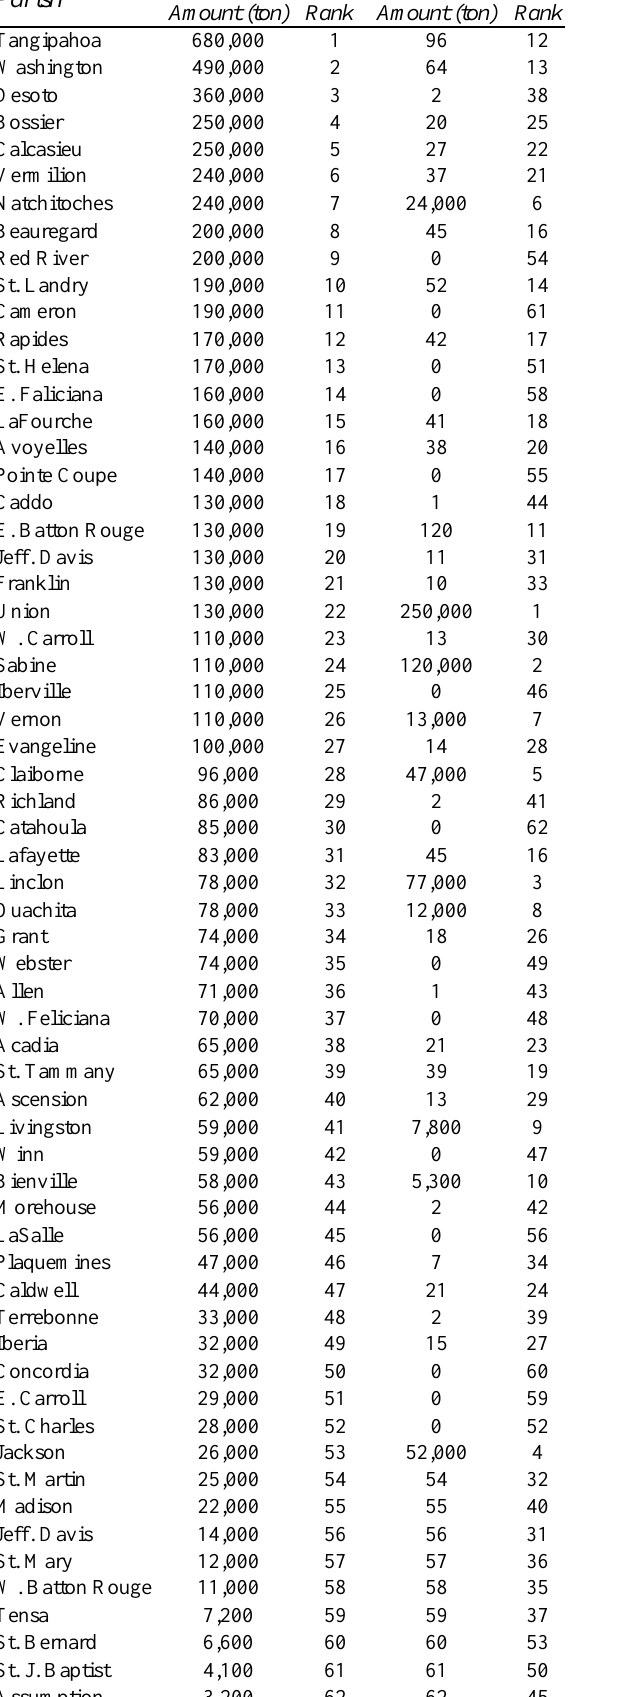
Table 3: Amount of cattle and poultry waste for Louisiana parishes and GetActive Software